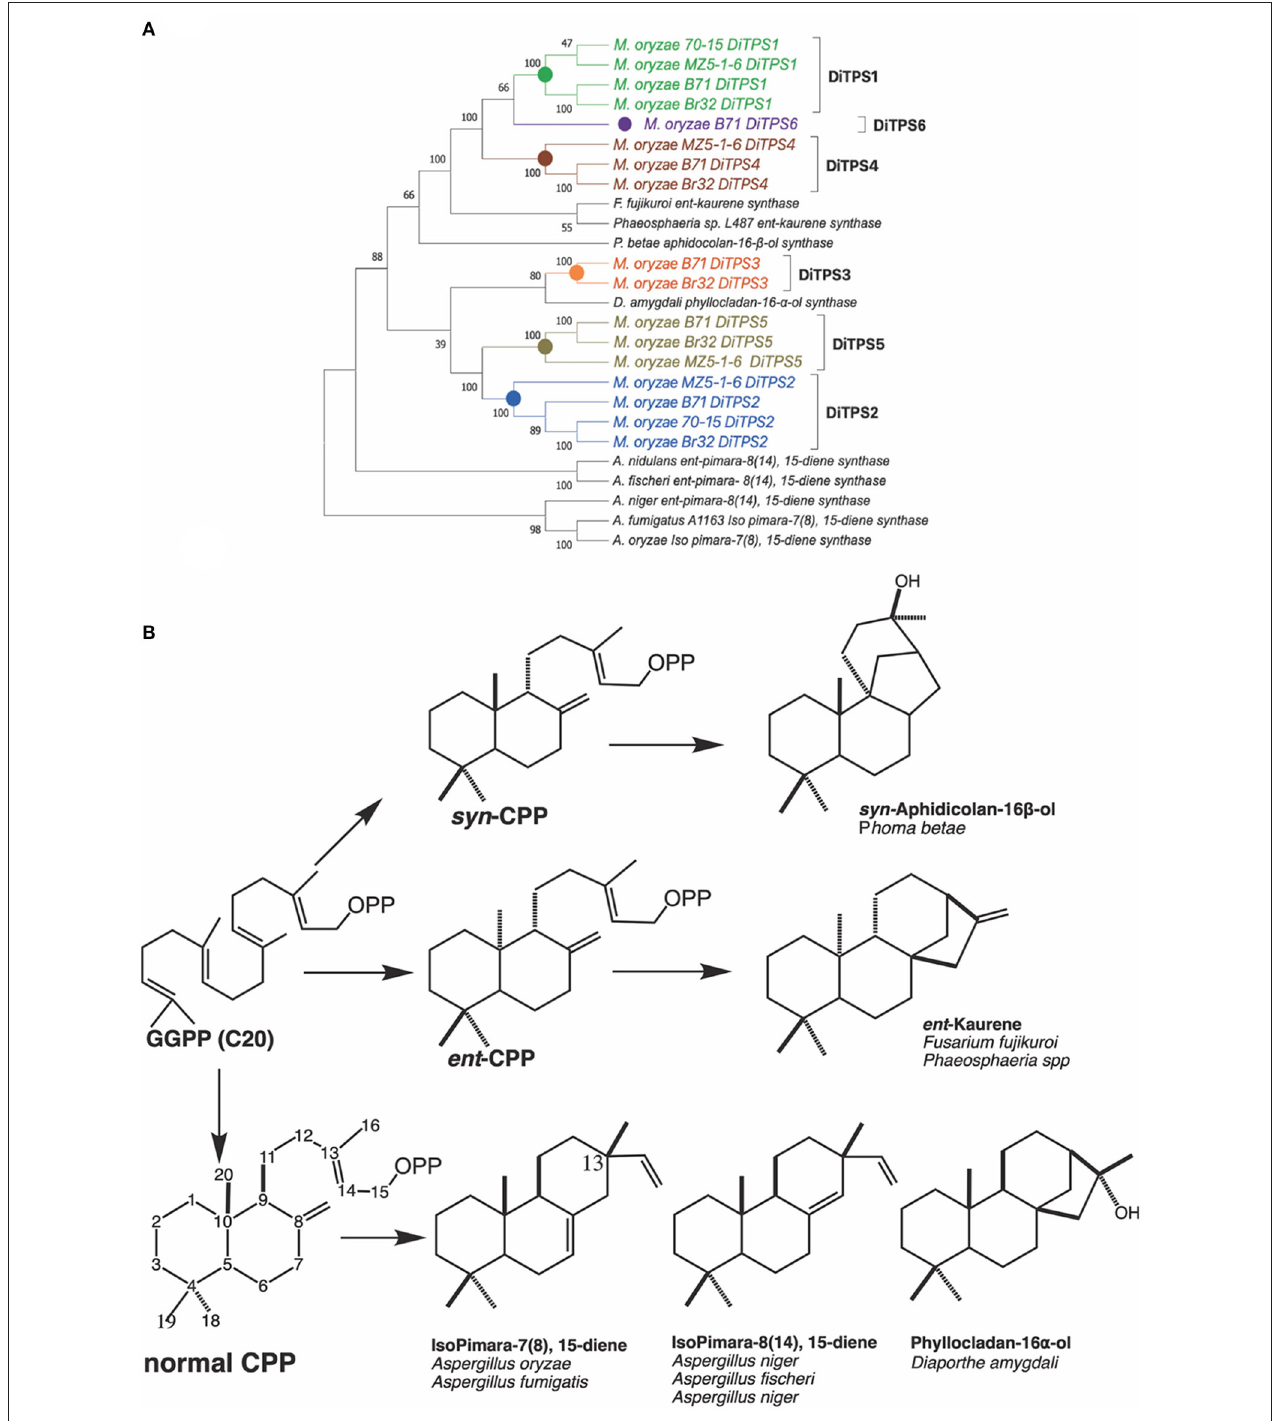
FIGURE 2 | (A) Phylogenetic tree of biochemically characterized diterpene synthases in Ascomycete. Unrooted maximum likelihood tree showing relationship between M. oryzae diterpene synthases and characterized diterpene synthases from various species from Ascomycete. Characterized diterpene synthases are depicted in black and M. oryzae genes in various colors. Bootstrap values were determined with 100 replicates using MEGA X. Genbank accession numbers of the characterized diterpene synthases are available in Supplementary Table 4 . (B) Structures of characterized diterpenes from Ascomycete. A summary of enzymatically characterized diterpene synthases from various fungi. Indicated is the intermediate stereoisomer of the Class II reaction and the resultant products mediated by the Class I active site. [ ent , syn , and normal stereoisomers are dependent on the orientation of methyl and hydride substituents C9, C10 bond. Orientation of the methyl group at C13 differntiates between isopimaradiene (C13 β ) vs. pimaradiene (C13 α )].